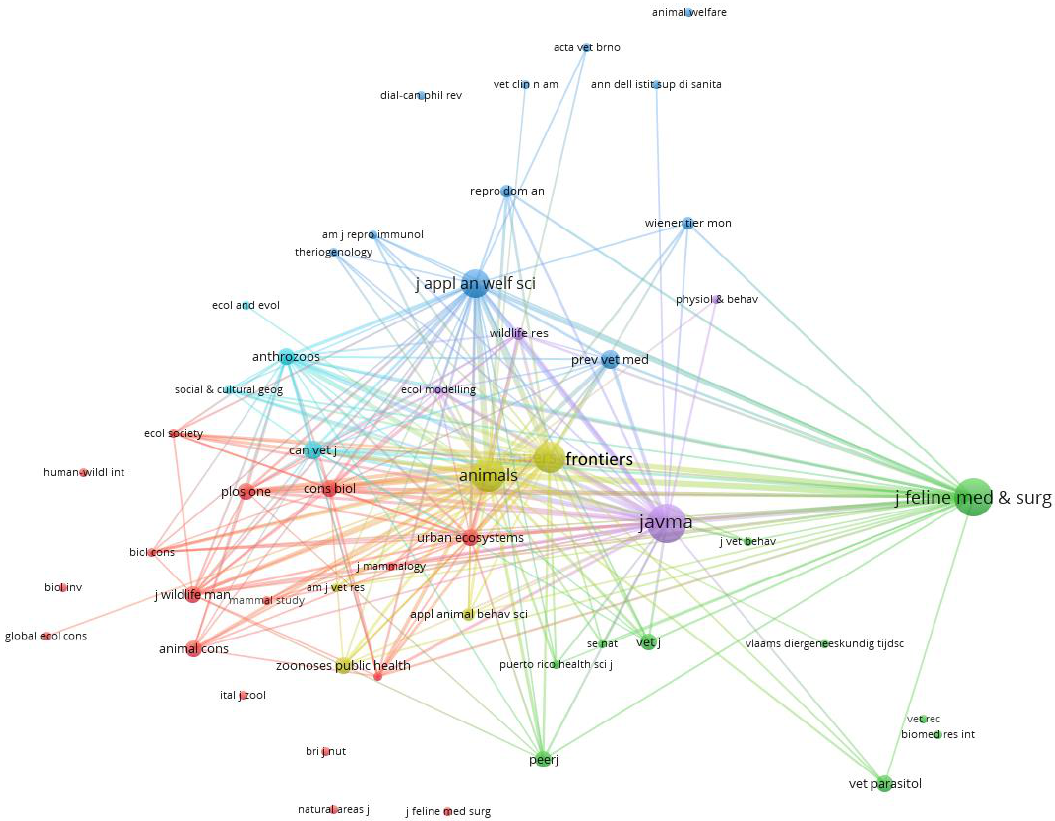
Figure 3. Networks for 145 papers published on TNR cat management showing bibliographic coupling links between publications in 55 journals. Here, each node (circle) represents one of 55 journals, with the Canadian Veterinary Journal and the Canadian Journal of Veterinary Research appearing as a single node as classified by the WoSCC journal abbreviation. Three papers published in Veterinary Dermatology, Revista Medica de Chile , and Journal of Veterinary Internal Medicine are not shown as they were off-scale of this image (and showed minimal connections). The size of the nodes represents the numbers of papers published in each journal, and the thickness of the lines represents the strength of bibliographic coupling, where the strength is determined by the number of shared references.